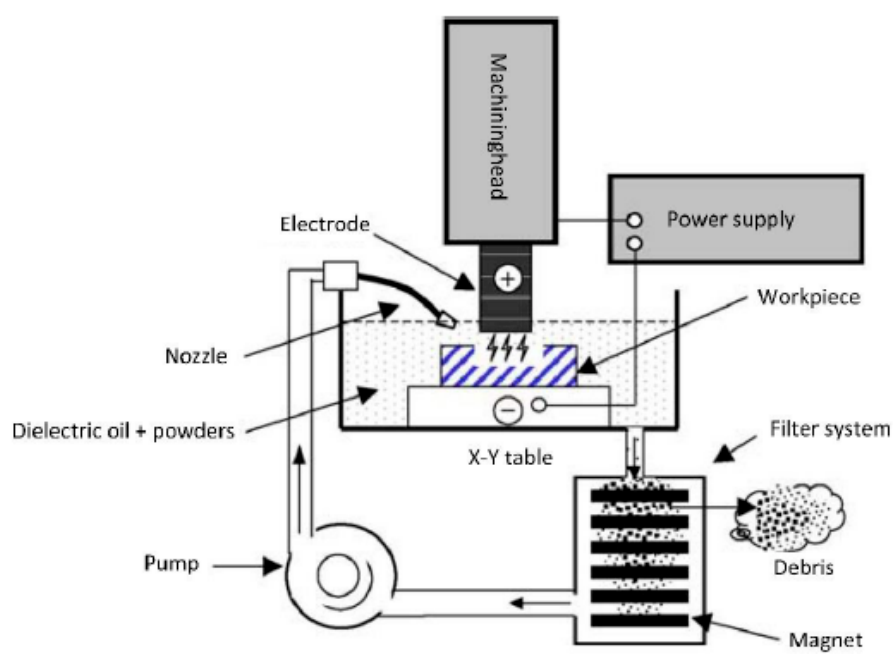
Figure 9. Representation of PMEDM Circulation Setup [112].